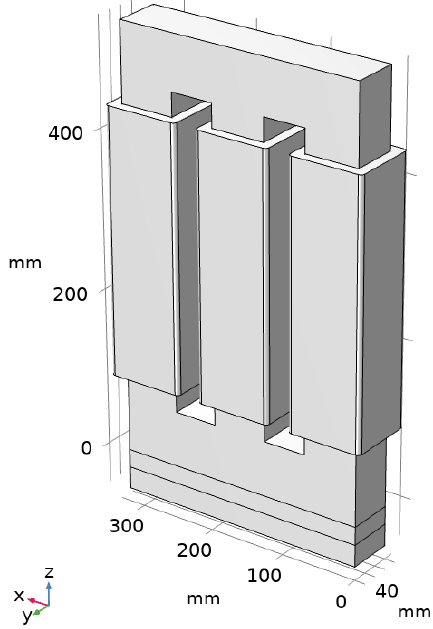
Figure 6. Three-dimensional numerical model.